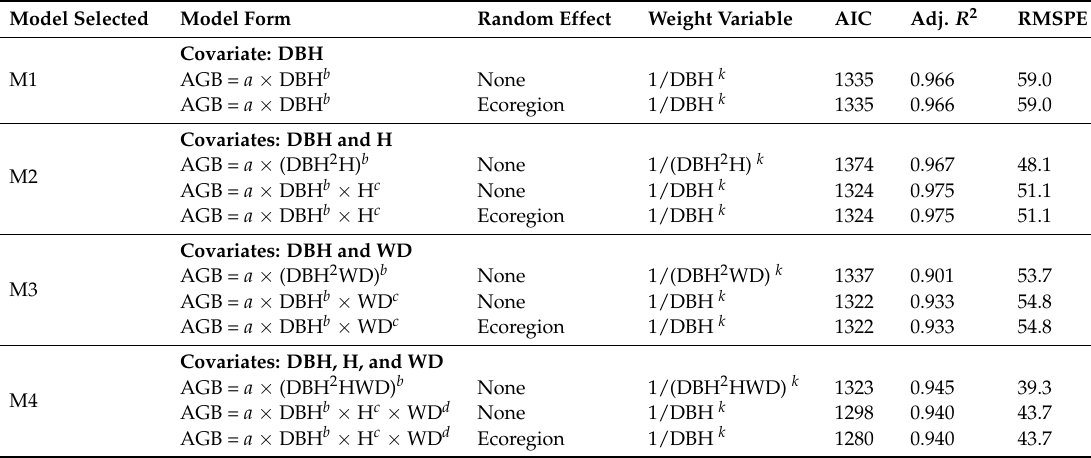
Table 3. Comparison of different AGB models for mixed-species with and without the random effect of ecoregion (156 trees).